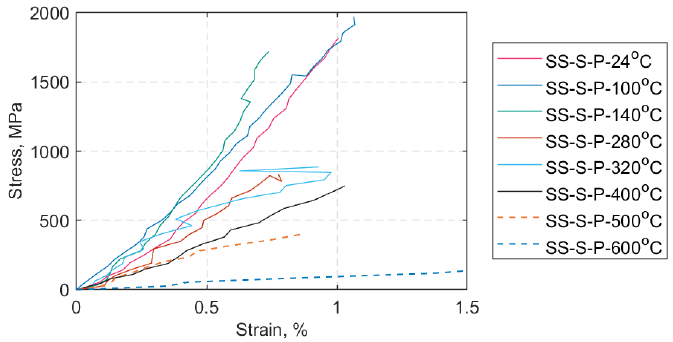
Figure 19. Force (kN) vs. crosshead stroke (mm) representative curves for each SS case.